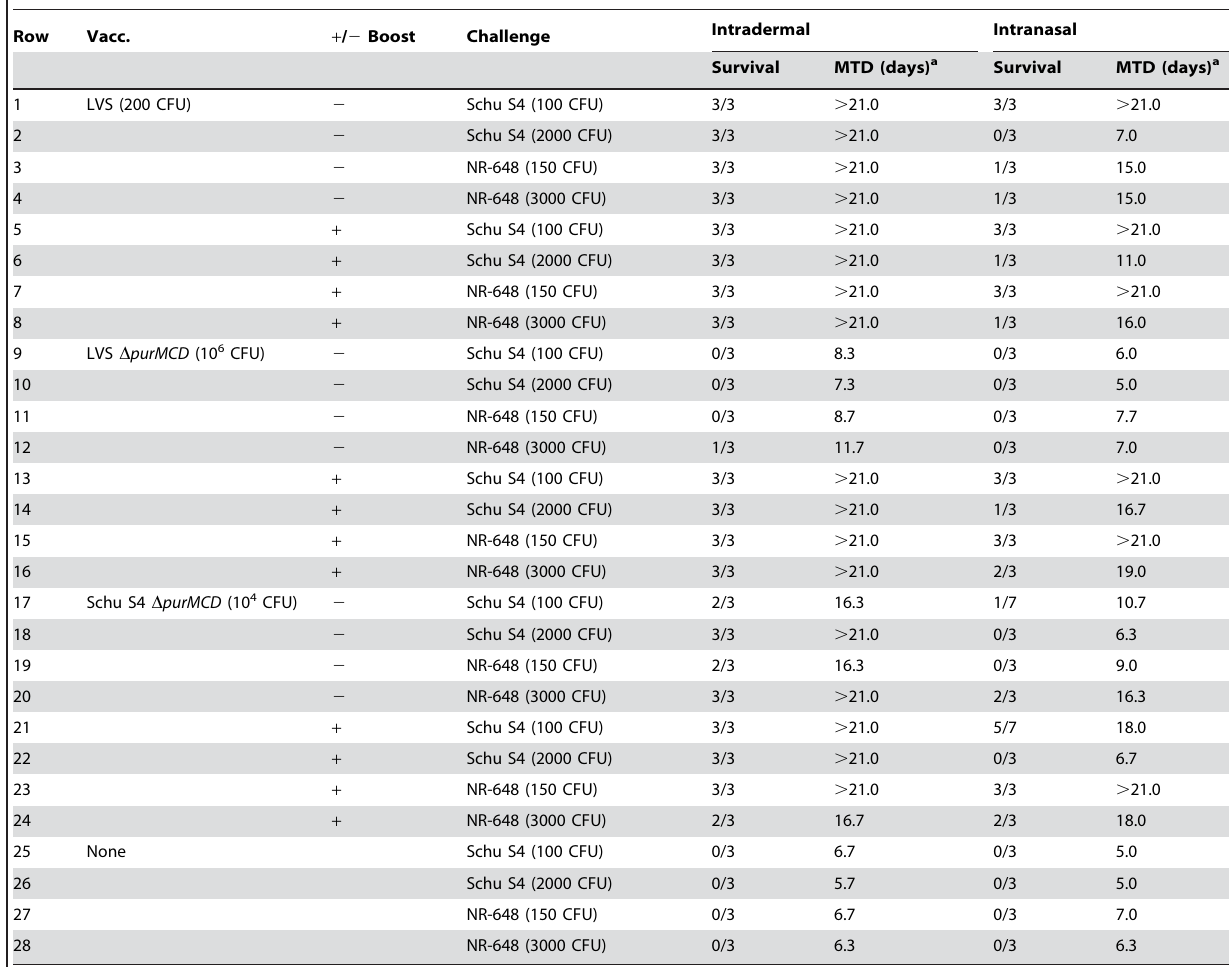
Table 2. Vaccination and Challenge results.